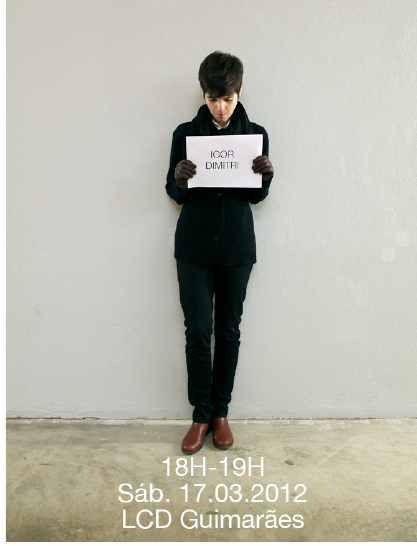
FIGURE 1 | Poster for performance